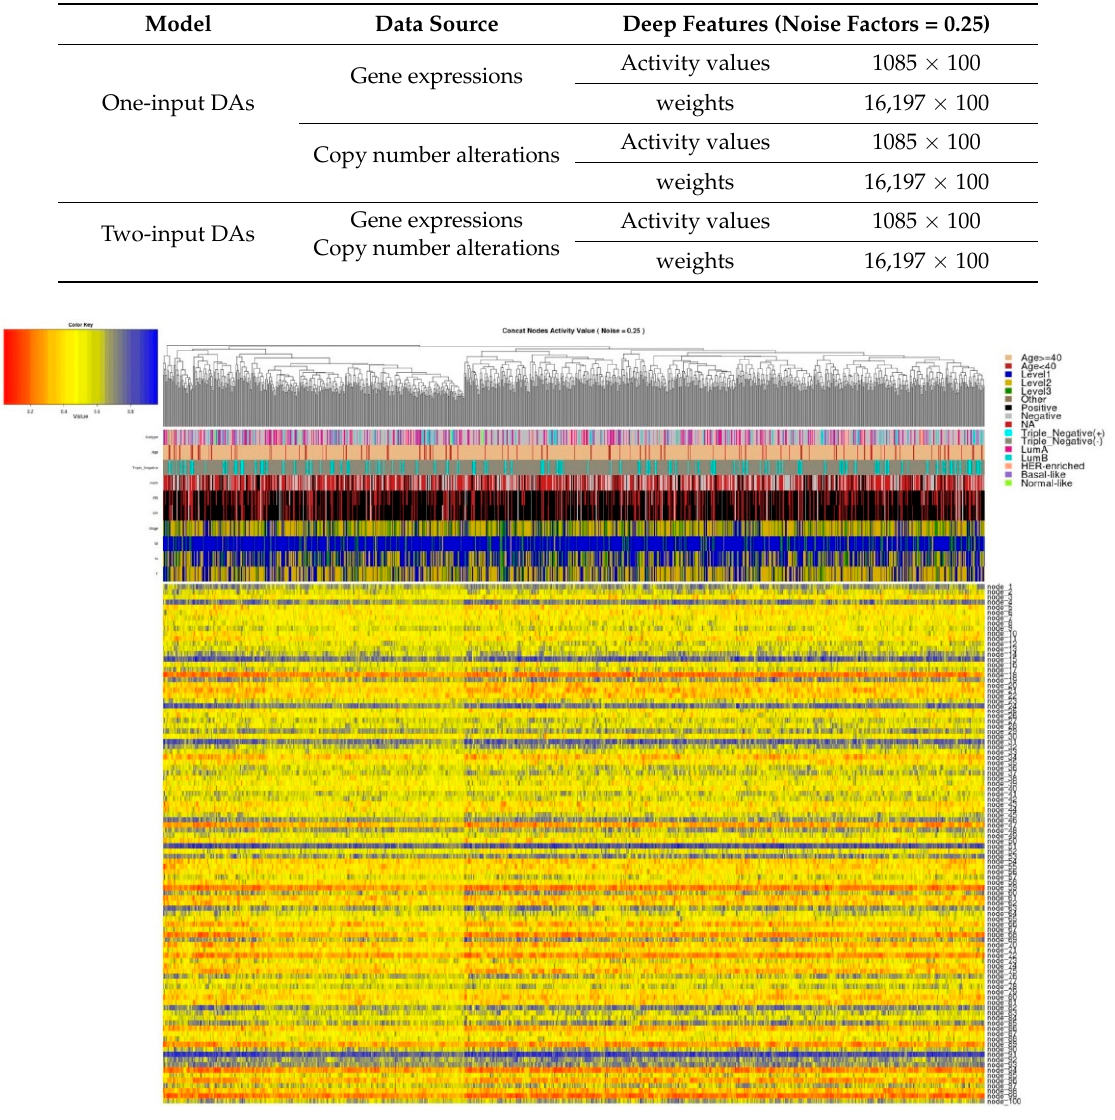
Table 1. The size and organization of deep features obtained from the models. The size and structure of the deep features extracted from gene expression data and copy number alteration data by the two denoising autoencoders (DAs) models.